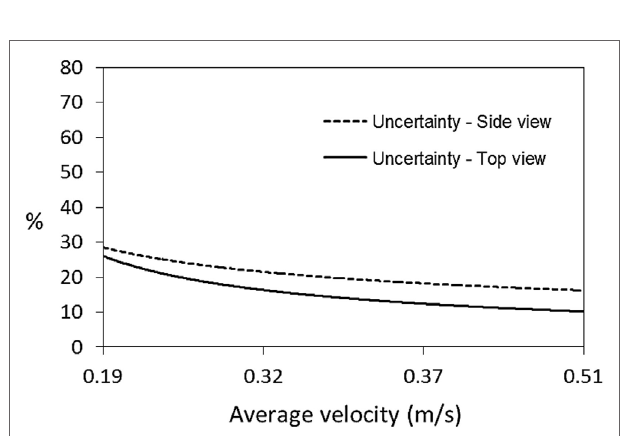
FigUre 8 | Time interval effect to measuring uncertainties of the atmospheric and 33 kPa vacuum cases